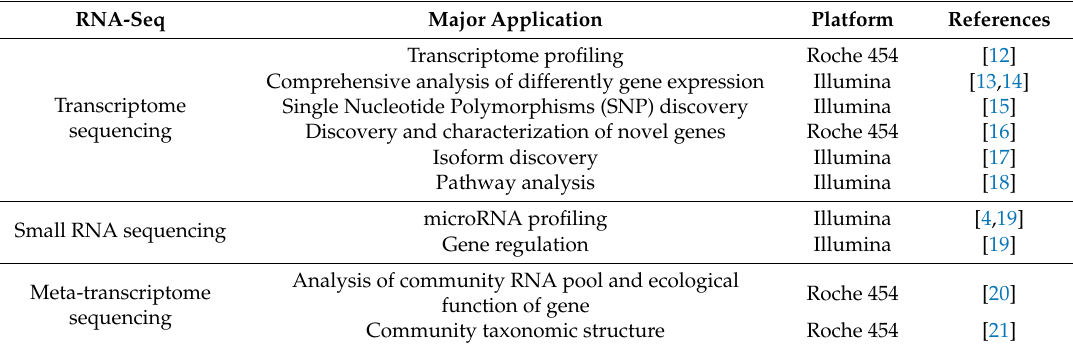
Table 1. Representative publication for application of RNA-seq in dinoflagellates transcriptome study.